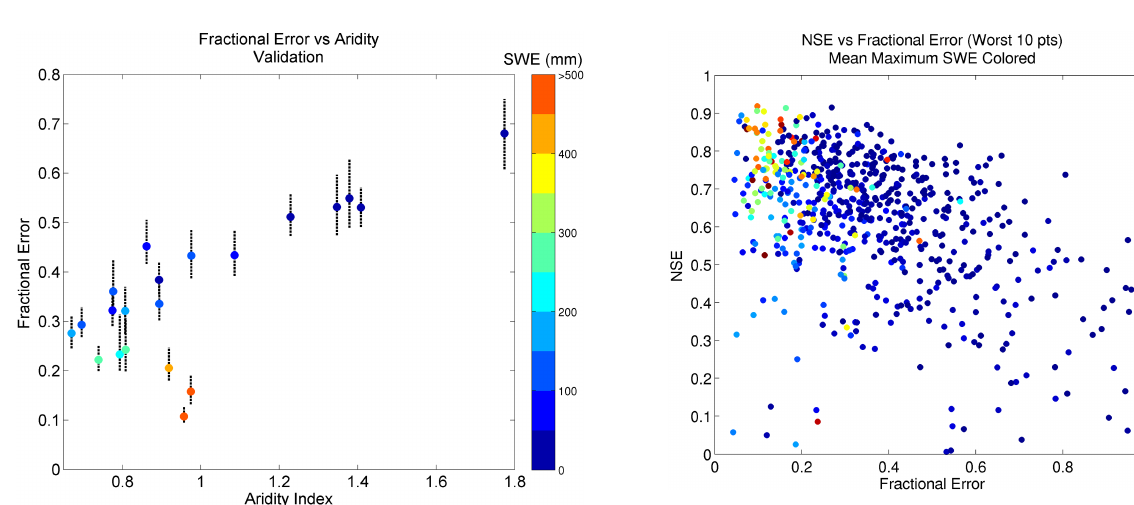
Figure 12. Ranked fractional squared error contribution for the 100 largest error days for the 671 basins versus the aridity index with mean maximum SWE shaded. Each dot represents a 32-basin bin defined by the rank of the fractional error contribution for the 100 largest error days for all basins. The dashed vertical black lines de- note the 95% confidence interval for the mean of the fractional error contribution for a given bin.